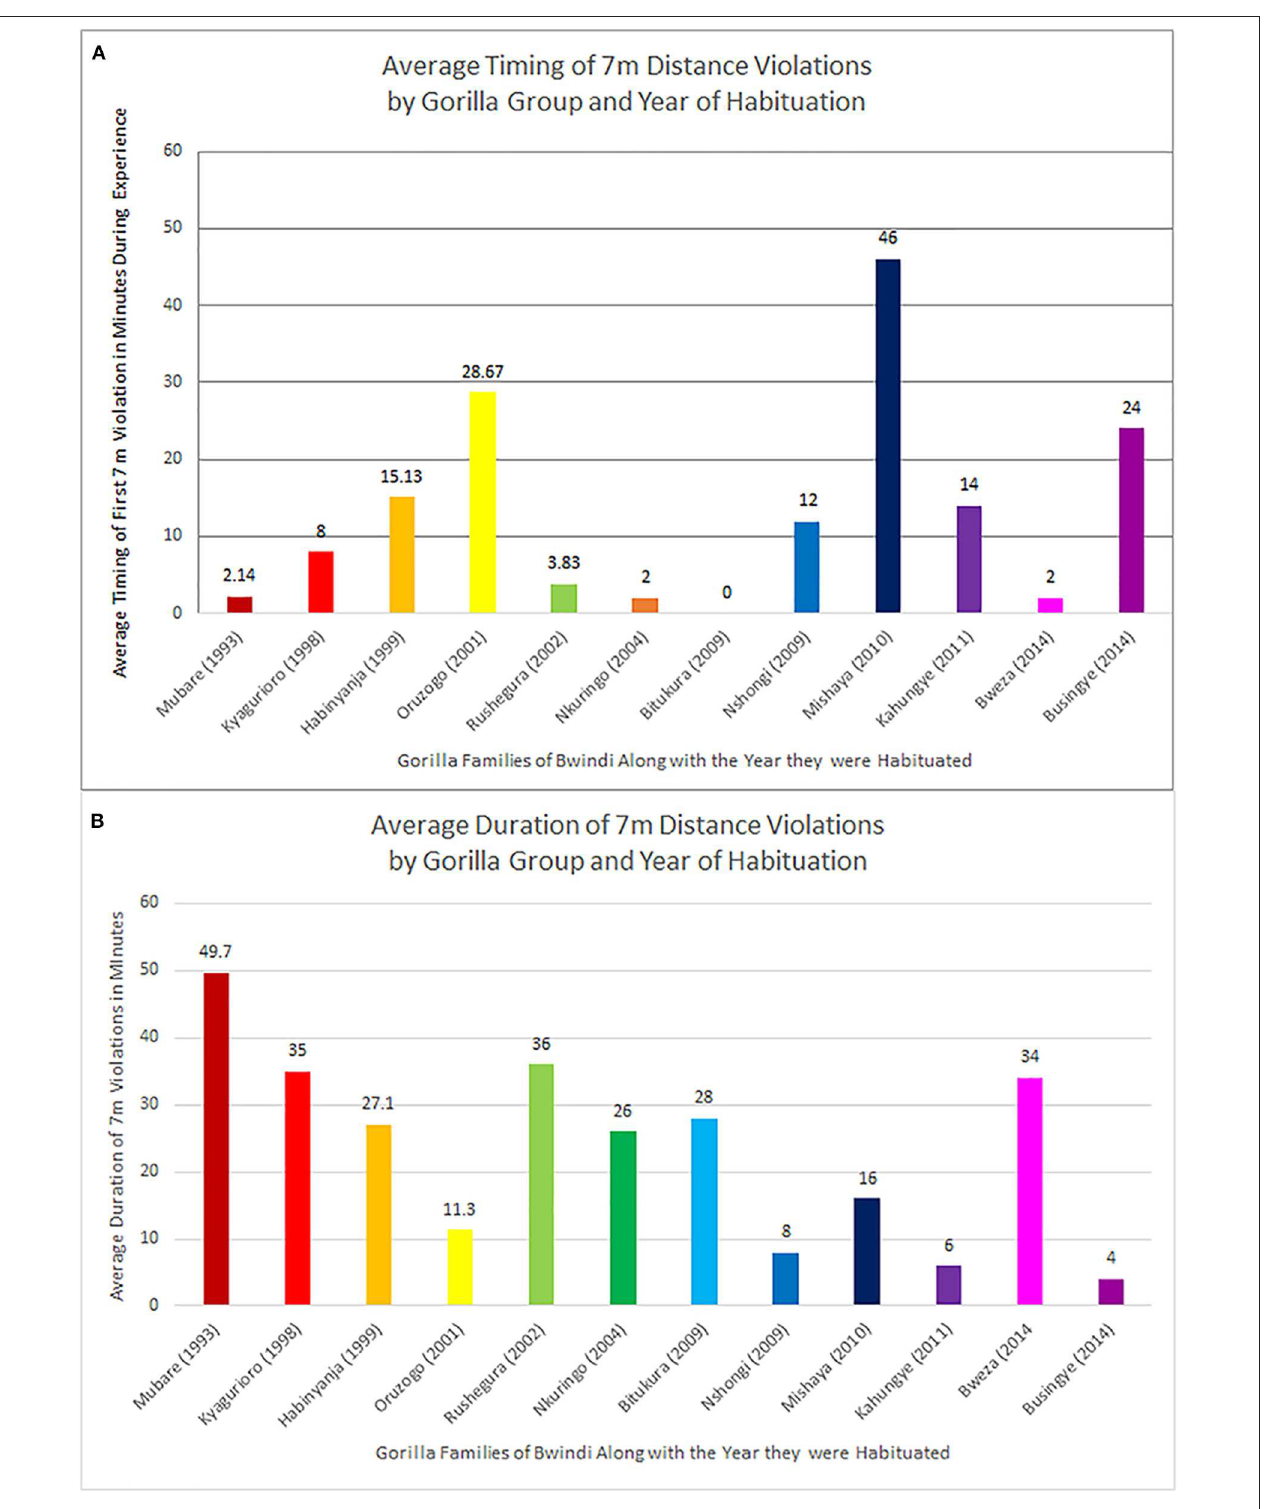
FIGURE 3 | Timing and duration of 7m rule violations for human-gorilla spacing during this study, by gorilla group and year of habitation. (A) Average time in minutes until first 7m rule violation during an hour-long viewing experience, as a function of gorilla group. (B) Average duration in minutes of 7m rule violations during an hour-long viewing experience, as a function of gorilla